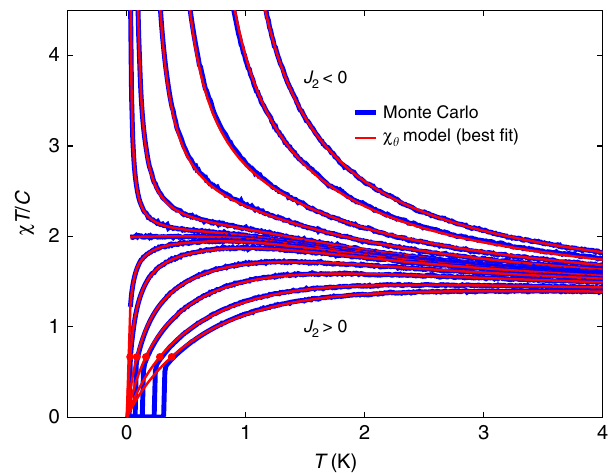
Fig. 1, we obtain a close match to the experimental data with this new parameter set labelled g + – DSM. We checked that such an